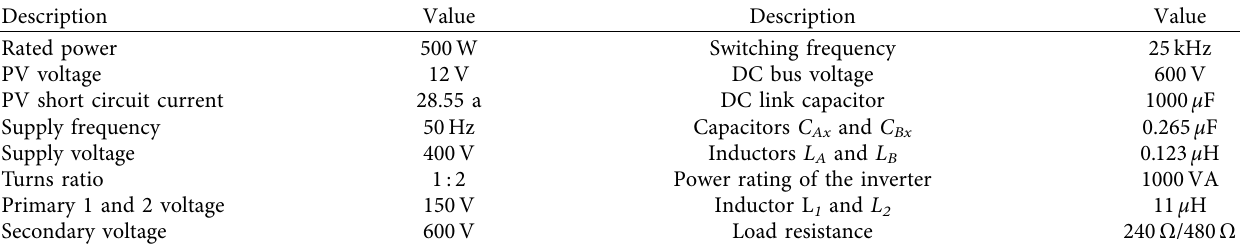
Table 2: System parameters of the simulated